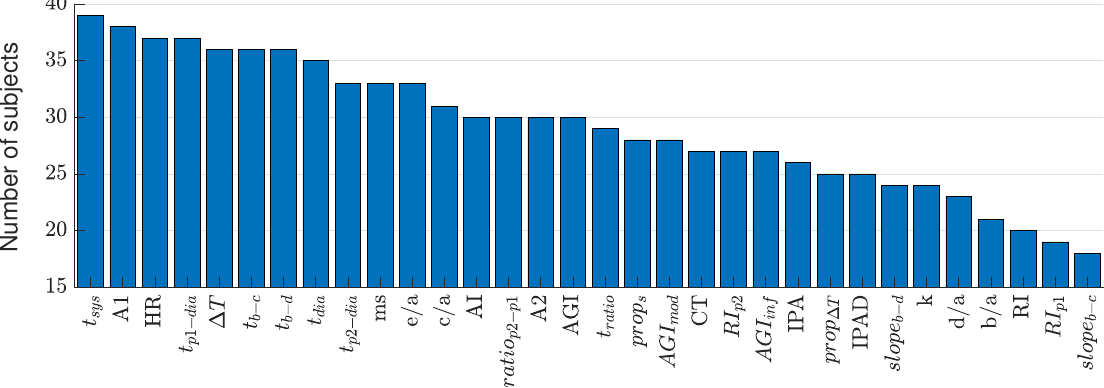
Figure 3. The number of subjects (out of 39) who exhibited a significant change in each VRR index in a particular direction after exercise. Indices are defined in the Abbreviations section (see end).